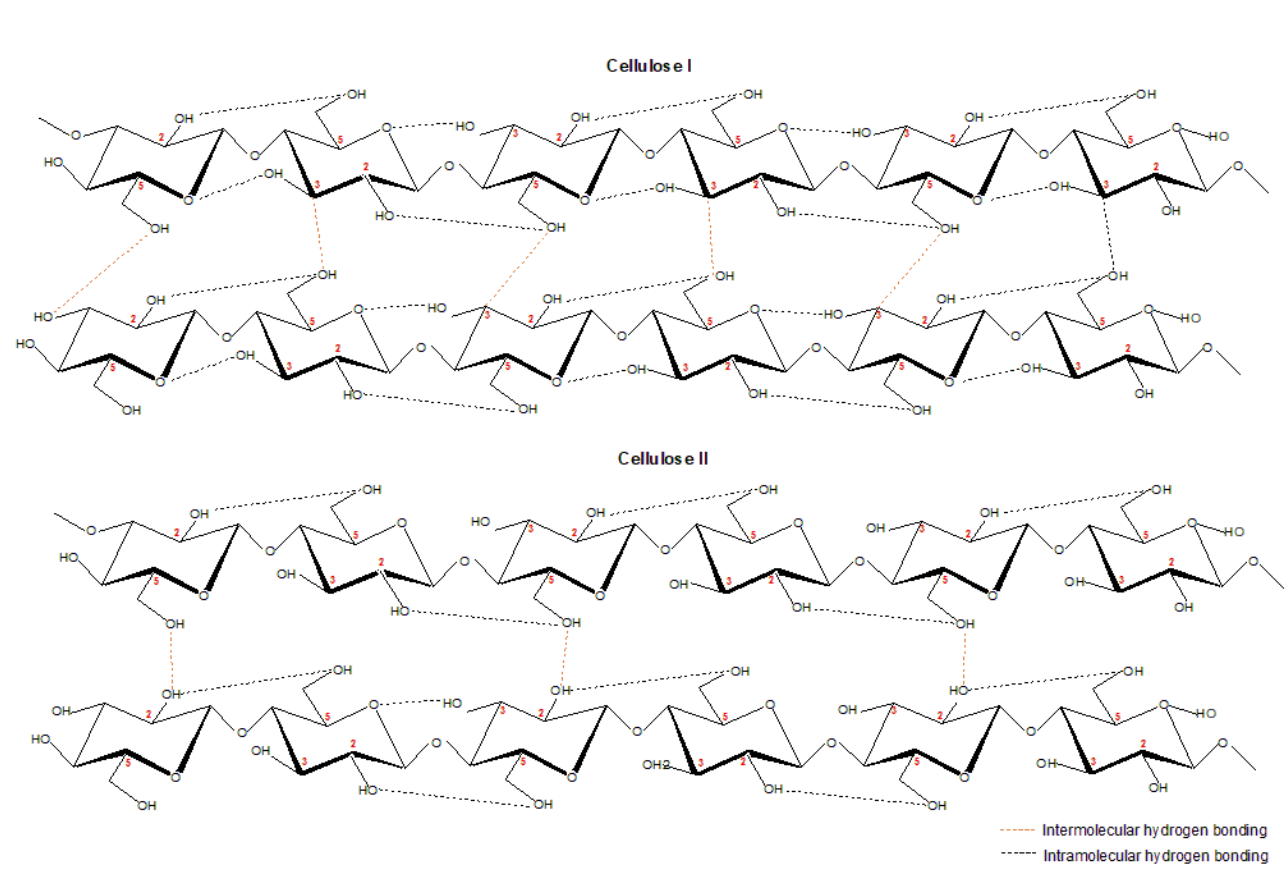
Figure 3. The structure of cellulose I and cellulose II. Table 2. The characterization of transformation of cellulose I to cellulose II via XRD, Fourier-transform infrared spectros- copy (FTIR), 13 C NMR, and Raman spectroscopy.